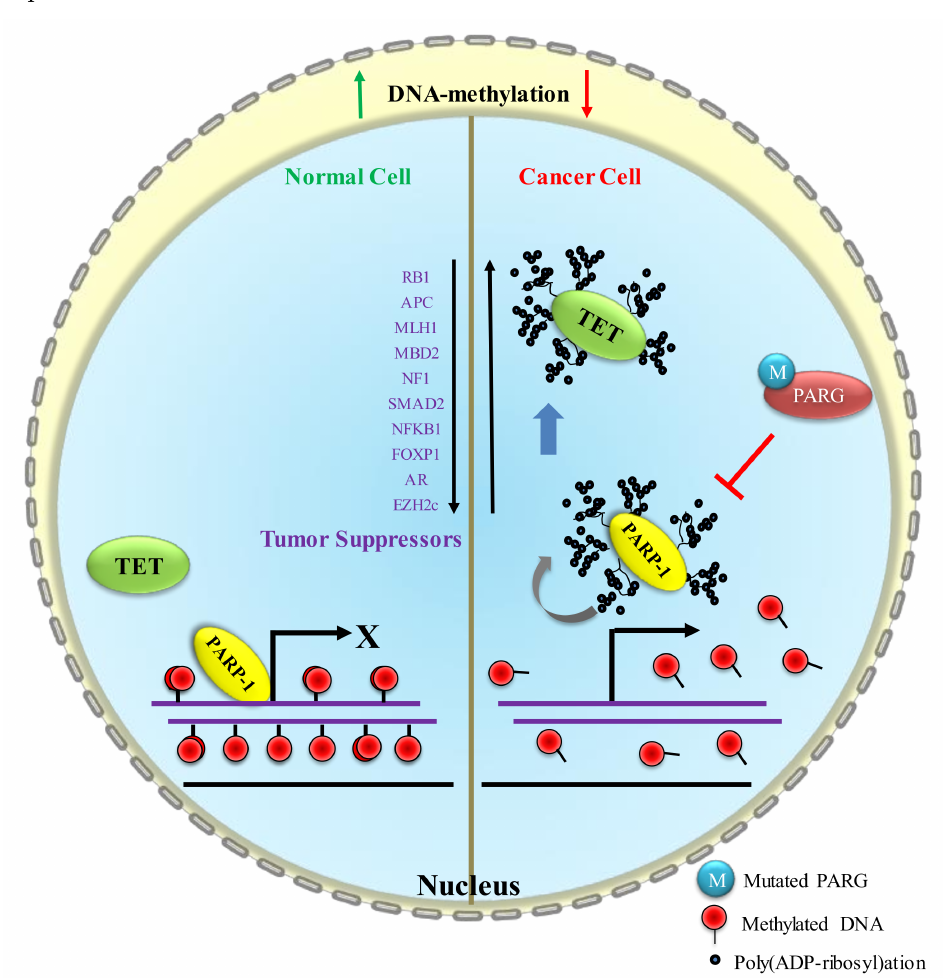
Figure 5. Enhanced poly(ADP-ribosyl)ation maintains DNA hypomethylation by activating TET1 functions. PARP1 binds to TSGs in their promoter region in normal cells. In PARG or homologous DNA-repair-defective cells, the enzymatic activity of PARP1 is increased (although TET1 activates PARP1 independently of DNA breaks) and poly(ADP-ribosyl)ated TET1 performs its DNA de- methylation function. It leads DNA hypomethylation on the regulatory regions of genes in cancer cells. Eventually, it facilitates the expression of TSGs; although this is not quite straightforward in malignant cells, it is a model to understand the functional dependency of proteins to each other and it is helpful to develop therapies by taking advantage of